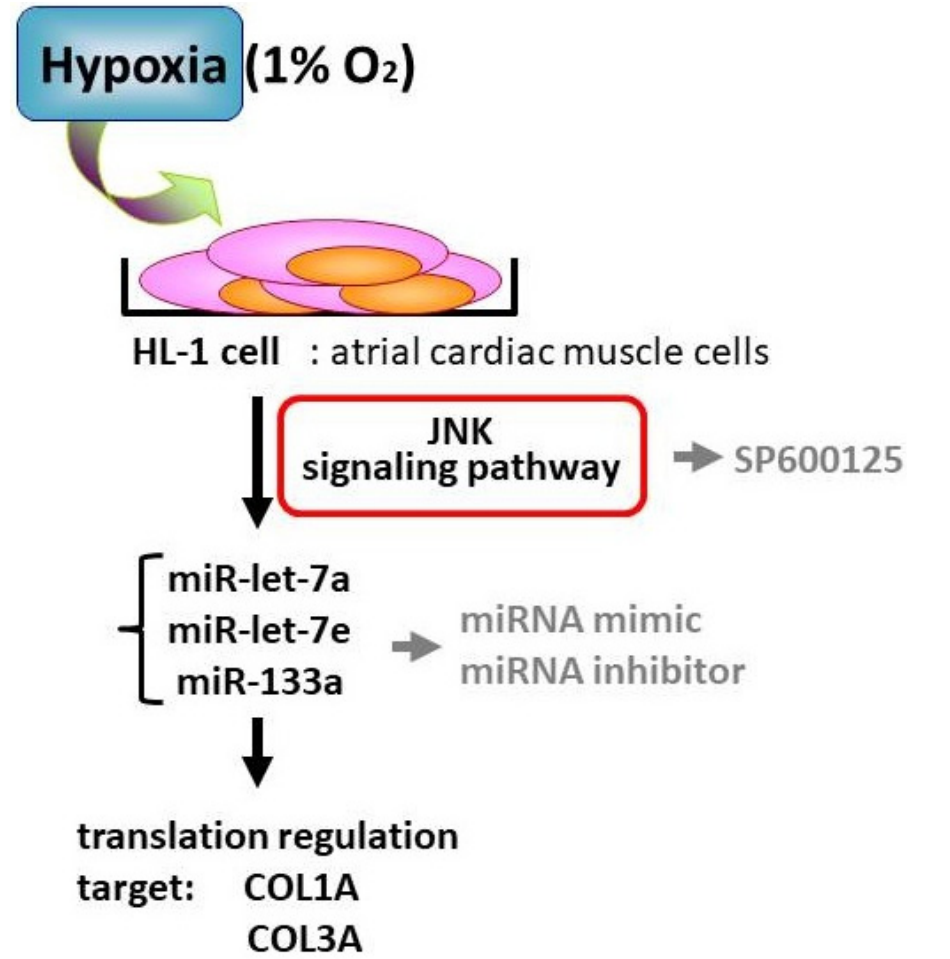
Figure 5. A proposed model of miRNA-mediated regulation of cardiac fibrosis under hypoxia by modulating JNK pathway.